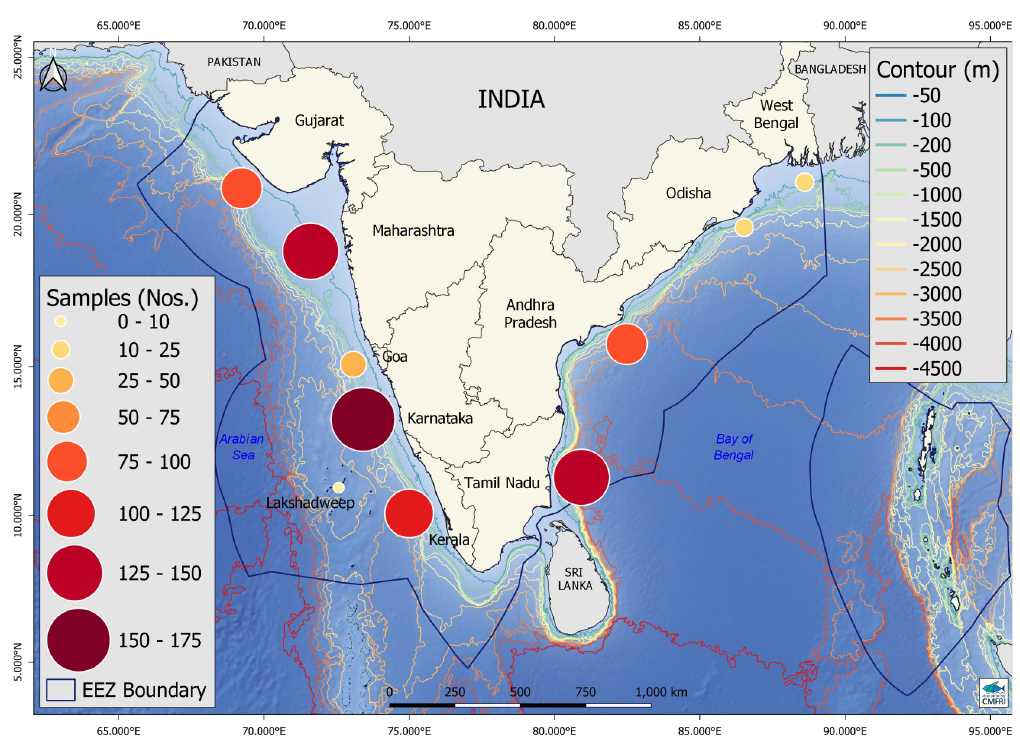
Fig 1. Map of coastal India showing the Arabian Sea, Bay of Bengal, the maritime state boundaries, and EEZ. Circles indicate the distribution of data records used in the study from different ecoregions. Base map and administrative boundaries sourced from the Natural Earth (http://www.naturalearthdata.com/); bathymetric data from the GEBCO gridded bathymetry data (GEBCO 2014 Grid, www.gebco.net); and EEZ boundaries from the Flanders Marine Institute Maritime Boundaries Geodatabase, version 11 (https://www.marineregions.org/).